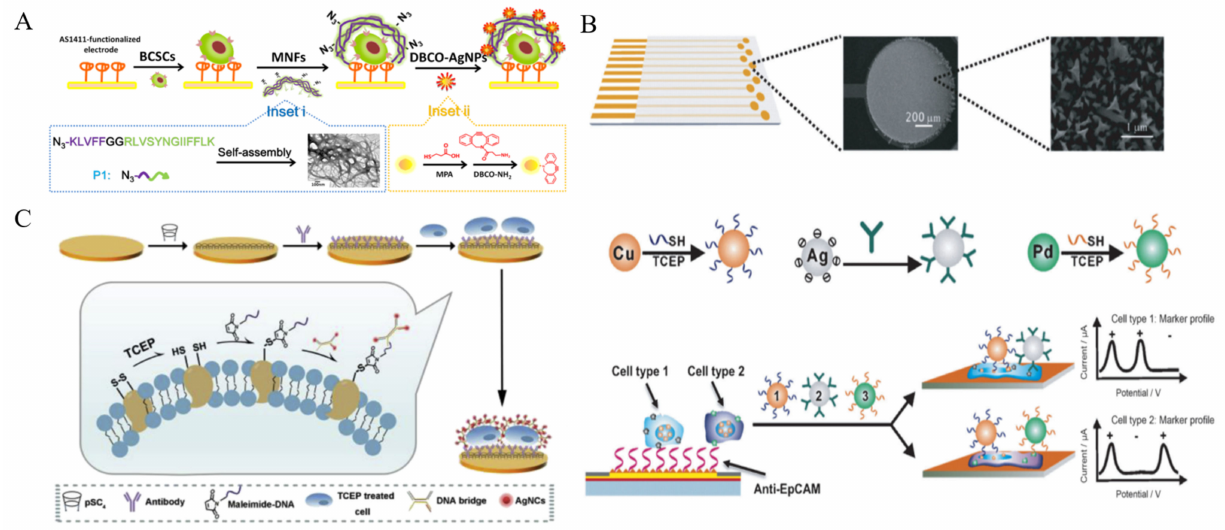
Figure 12. ( A ) Schematic representation of the multifunctional nanofiber-assisted EC identification of BCSCs [210]. Copy- right 2019 American Chemical Society. ( B ) Schematic representation of the multi-nanoparticle approach to specific cancer cell detection [212]. Copyright 2014 Wiley-VCH. ( C ) Schematic representation of signal labeling and electrochemical sensing of cancer cells via mild reduction [213]. Copyright 2019 Elsevier